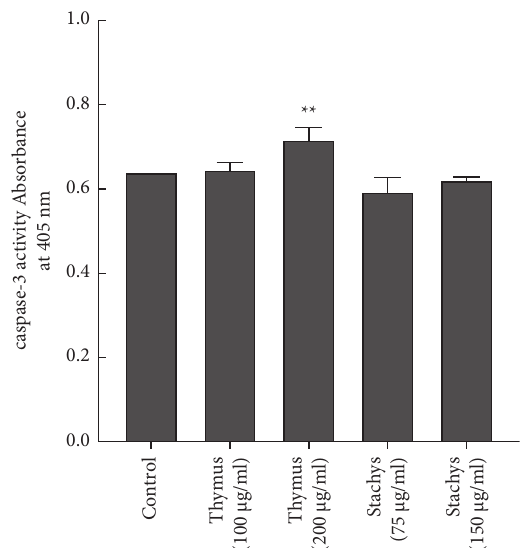
Figure 4: Effect of the S. pilifera Benth and T. daenensis Celak extracts for 24 h on the caspase-3 activity in HepG2 cells ( ∗∗ P < 0 . 01, in comparison to the control).